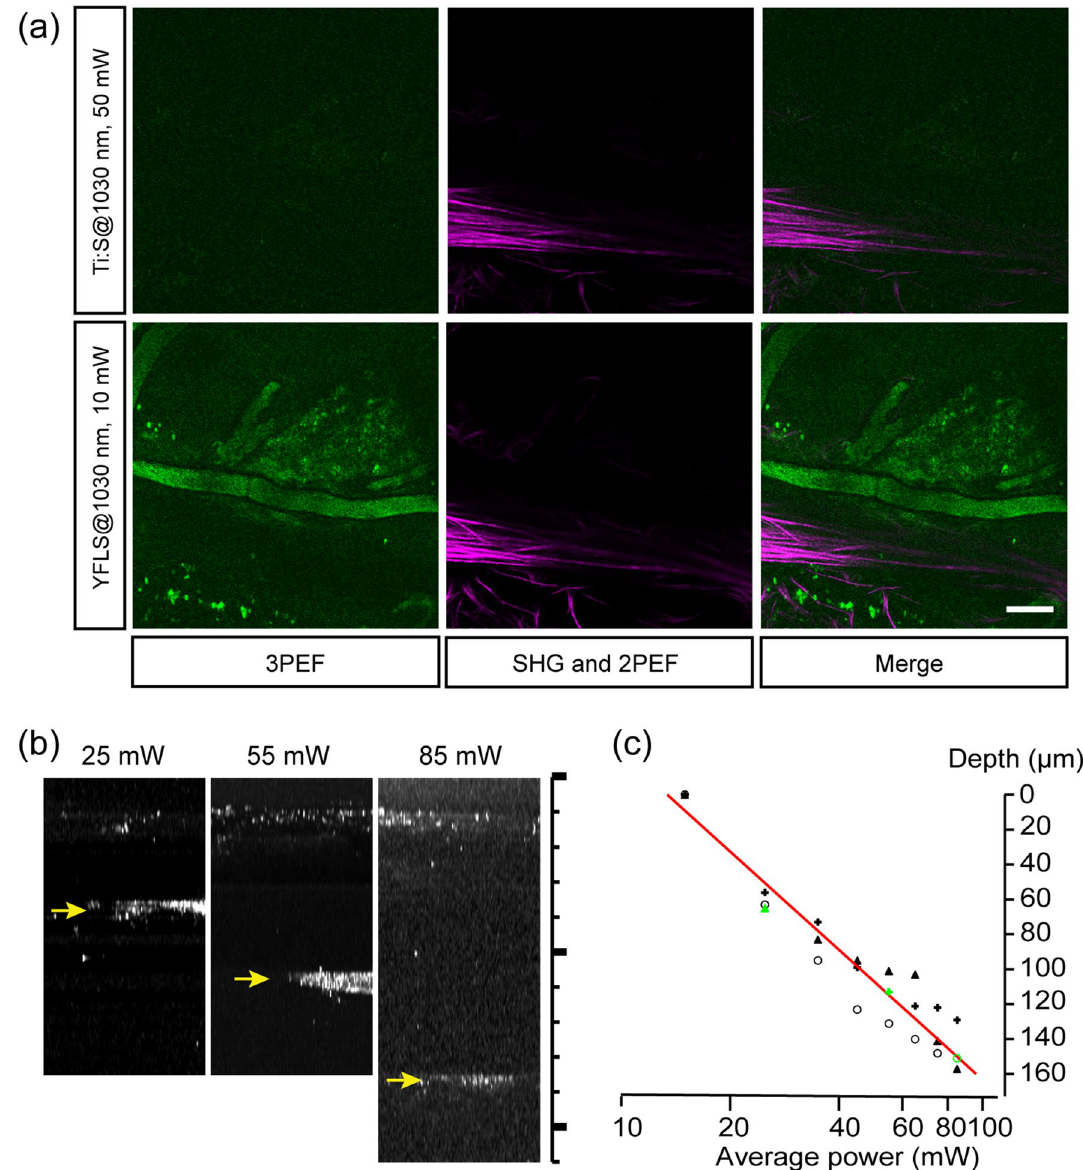
Figure 4. Photodamages in the live brain by high-pulse-energy MPM. ( a ) The superficial cortex imaged by the YFLS and the Ti:Sapphire laser at the same wavelength and 2PE equivalent average power. Scale bar, 50 µm. ( b ) Axial projections showing the depth of photodamage at various average powers (arrows). Scale bar, 220 µm. ( c ) The depth profiles of photodamage (N = 3 mice) and the best fit (red). Green markers indicate the data shown in ( b